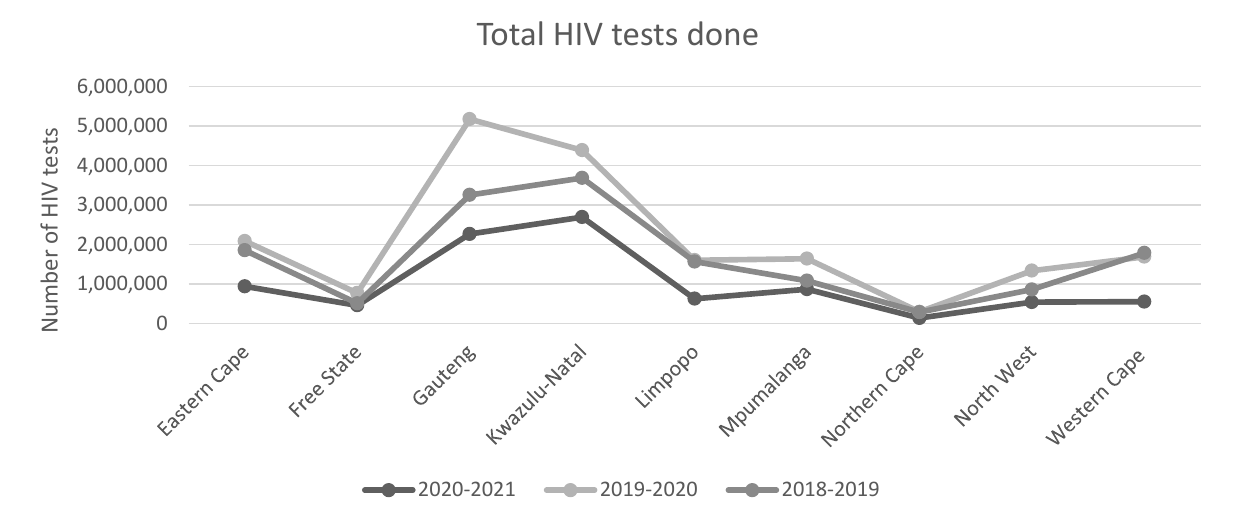
number of HIV tests being conducted. A significant decrease in testing and positive tests was seen